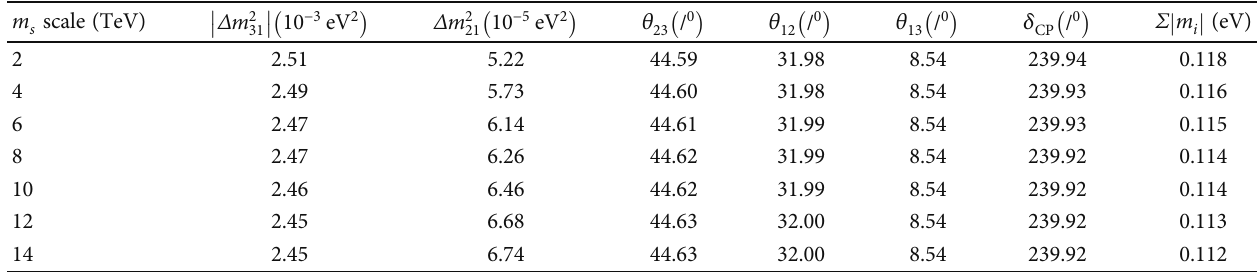
Table 16: E ff ects on the output of neutrino parameters at low energy scale, on varying m scale are di ff erent choices of M R